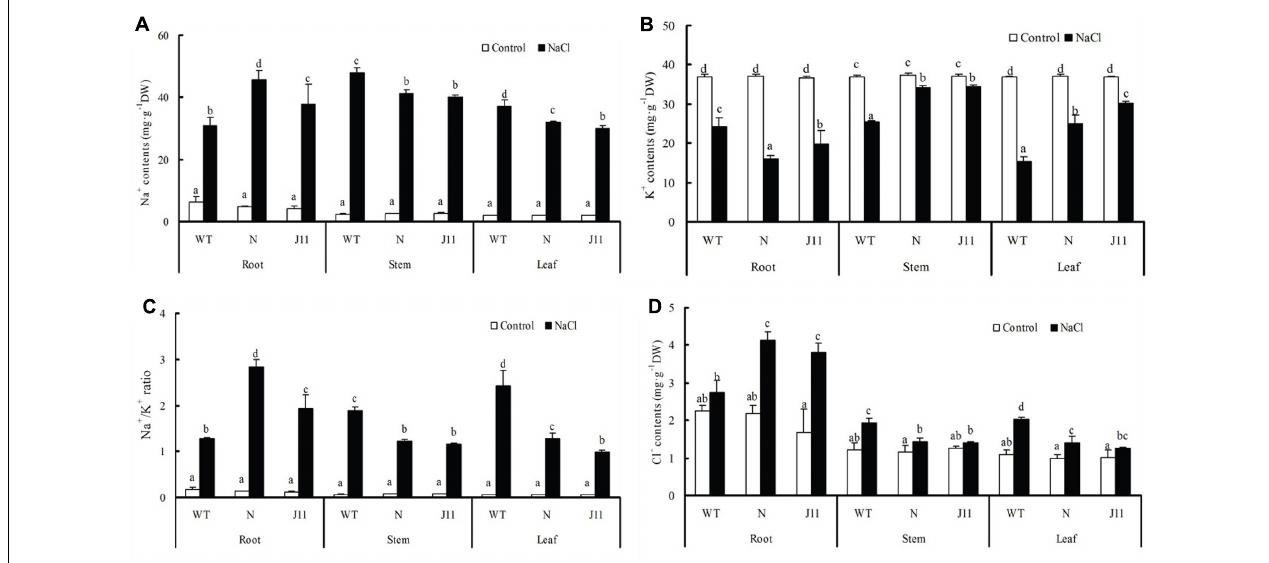
FIGURE 6 | Changes in ion contents of plants of PgTIP1- transgenic soybean lines and WT under NaCl treatment. The plants of WT and PgTIP1 transgenic soybean lines N and J11 were cultured and NaCl-treated as above-mentioned in Figure 4 . After 7 days treatment, the roots, stems and leaves (including the 1st pair of unifoliolate, the 1st and 2nd trifoliate leaves) were sampled for measuring contents of (A) Na + and (B) K + , (C) Na + /K + ratios, and (D) Cl − content. Each bar represents the mean and SD of three replicates, means in bars followed by different letters show significant difference ( P < 0.05) between the parameters of WT and PgTIP1- transgenic